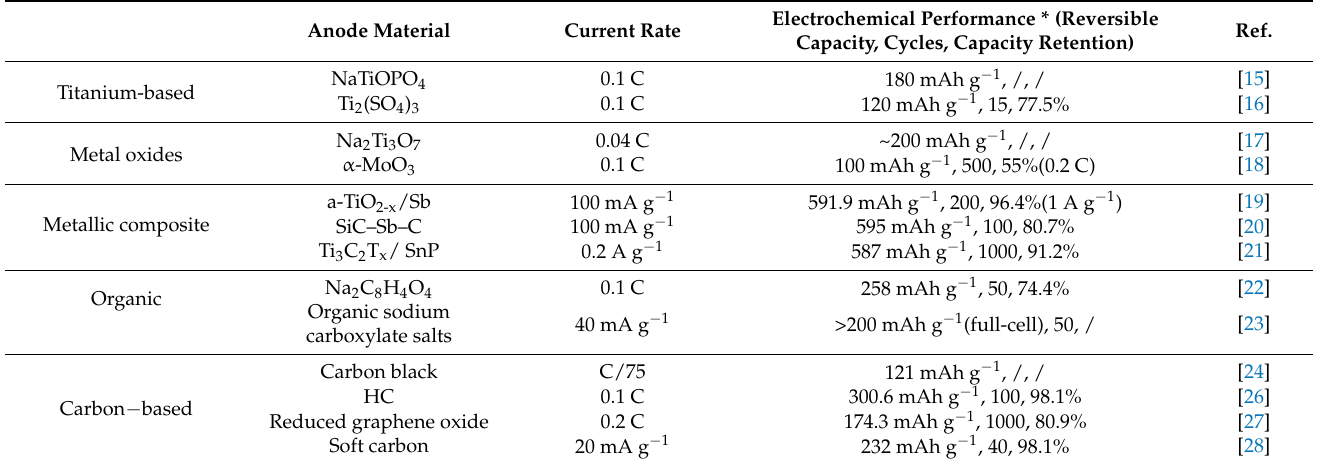
Table 1. Different kinds of anode materials in